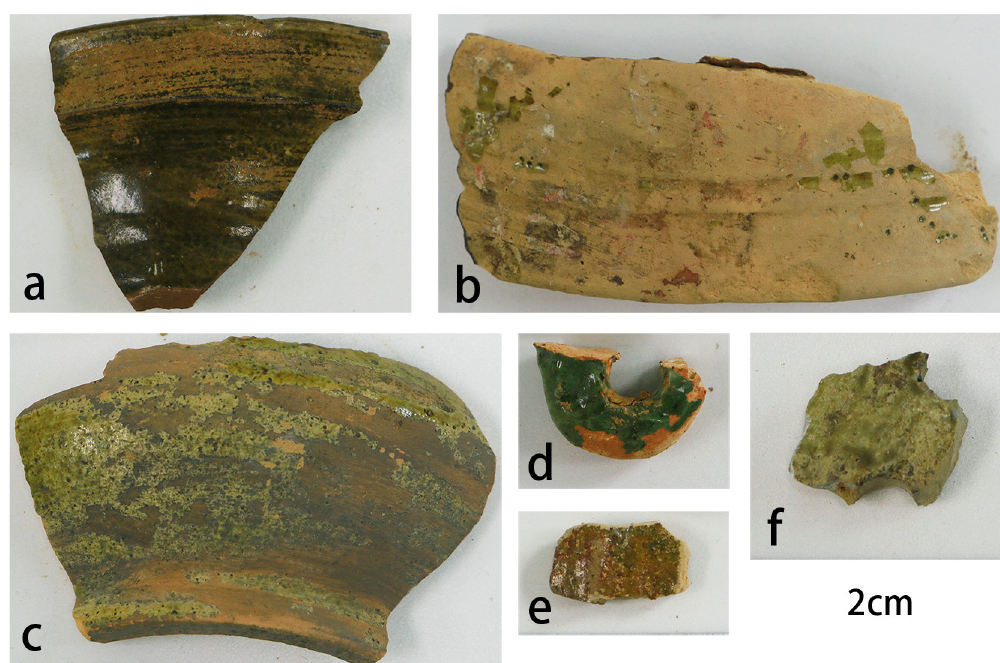
Fig 1. The appearance of the representative samples. (a) The sample No. 24 with dark green glaze and hard ceramic body, (b) The sample No.14 with yellow green thick glaze, (c) The sample No. 04 with yellow green thin glaze and loose ceramic body, (d)The sample No. 23 with emerald glaze, (e) The sample No. 02 with dark green glaze, (f) The sample No. 19 with yellow green glaze with